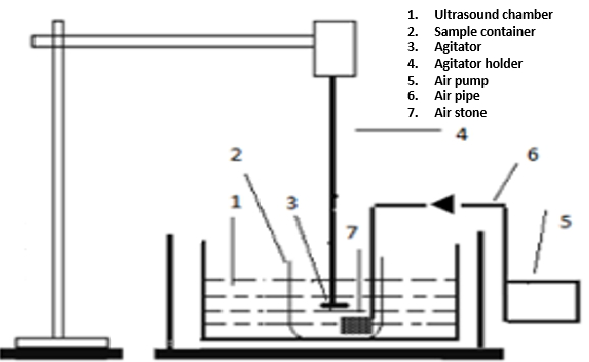
Fig. 1. Schematic design of the reactor